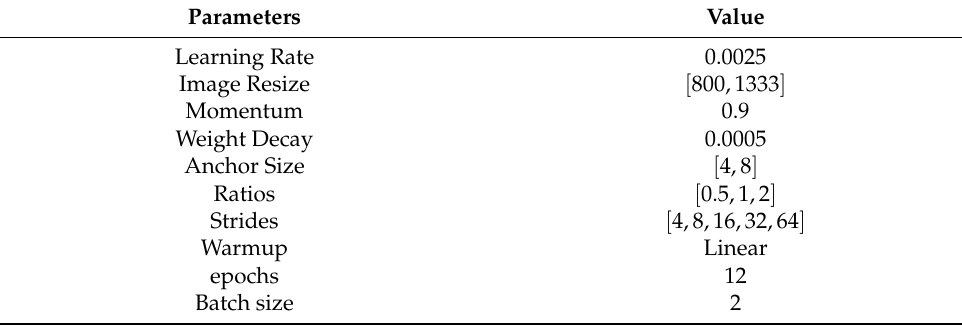
Table 3. Experimental training parameters and anchor generation rule